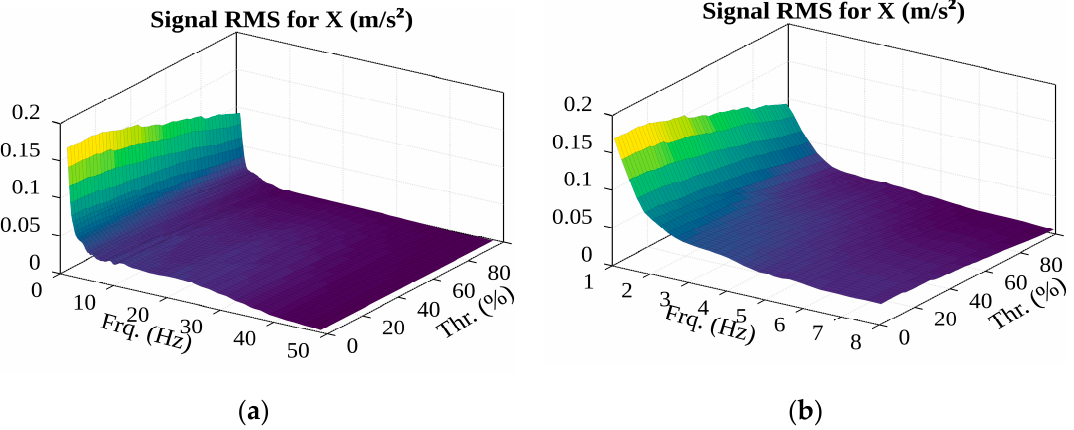
Figure 25. The surface of RMS of potential events amplitudes (in the ( a )—1–49 Hz; ( b )—1–8 Hz frequency range).